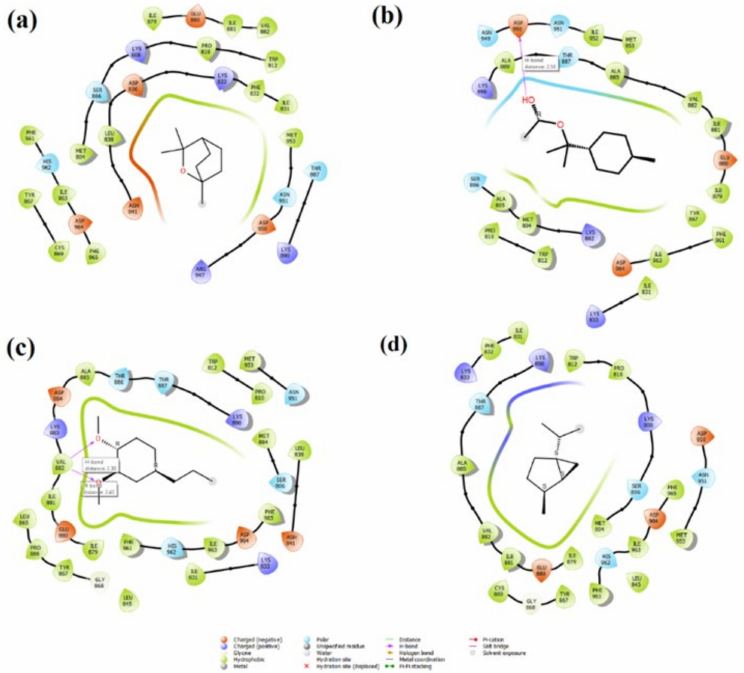
Figure 9. The 2D interactions of the major components of the LNEO (1,8-cineole ( a ), α -terpinyl acetate ( b ), methyleugenol ( c ) and sabinene ( d )) with the PI3K/mTOR target